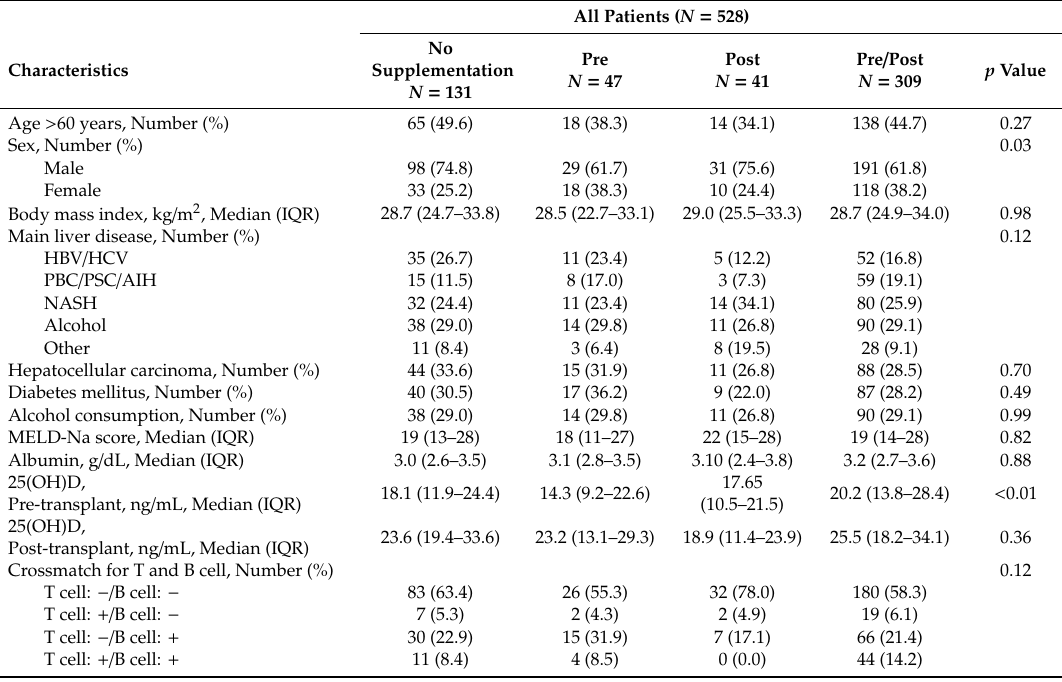
Table 4. Comparison of patient characteristics among di ff erent vitamin D supplementation statuses.